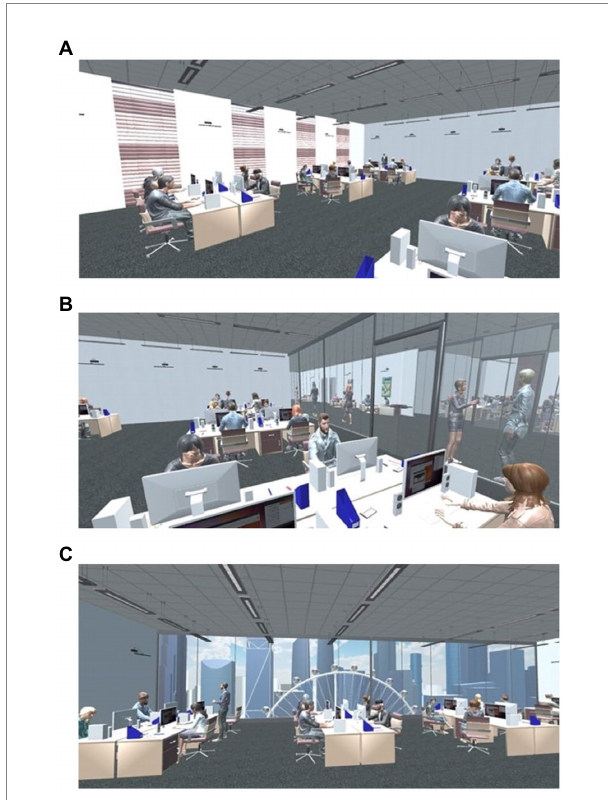
FIGURE 2 The different office view types from the perspective of the participant. (A) = no view office; (B) = internal view office; (C) = outdoor view office. Reproduced with permission from Jicol et al. (2023).